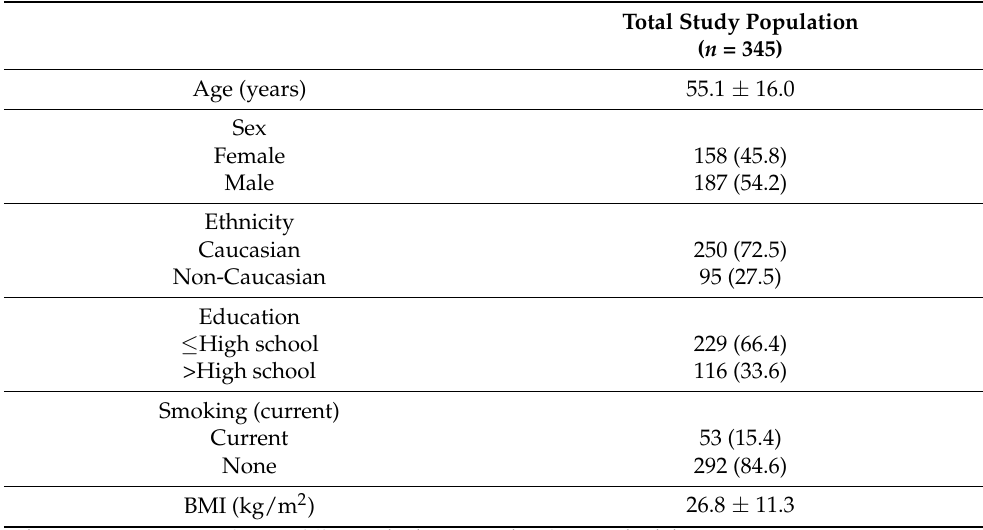
Table 1. Characteristics of the study population.